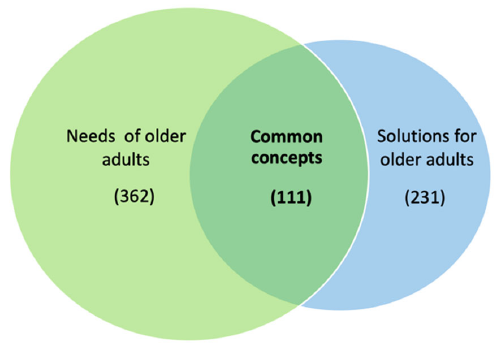
Figure 3. Concepts analysis chart. (Source: developed by the authors).